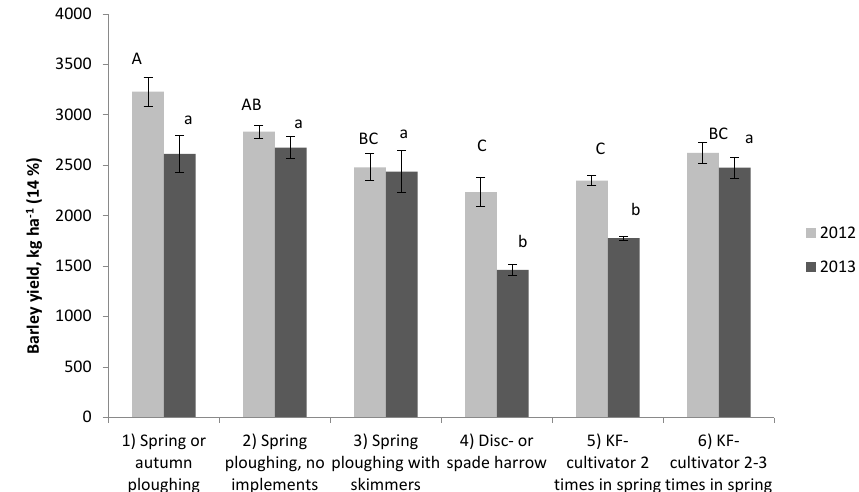
Fig. 2. Average barley yields (kg ha -1 ) in experiment 1 (moisture content 14 %). The experiment was conducted in the same fixed place during 2012–2013. Standard deviations of the treatments are marked with bars (n = 4). The treatments with different letters were significantly different at 95% confidence. Note: The significance can be compared only within years, not between years.